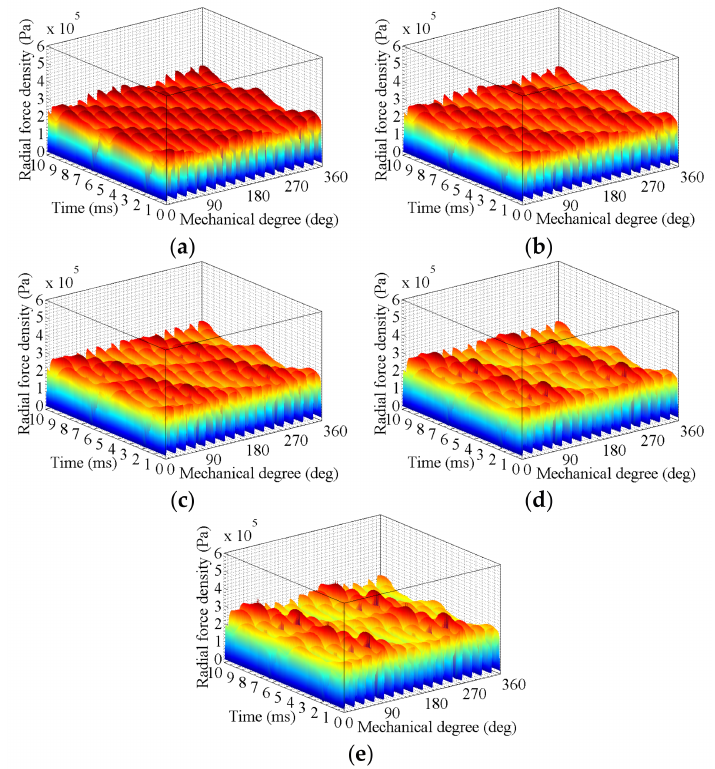
Figure 5. Radial force density in the IPMSM with stator deformation at no-load condition.